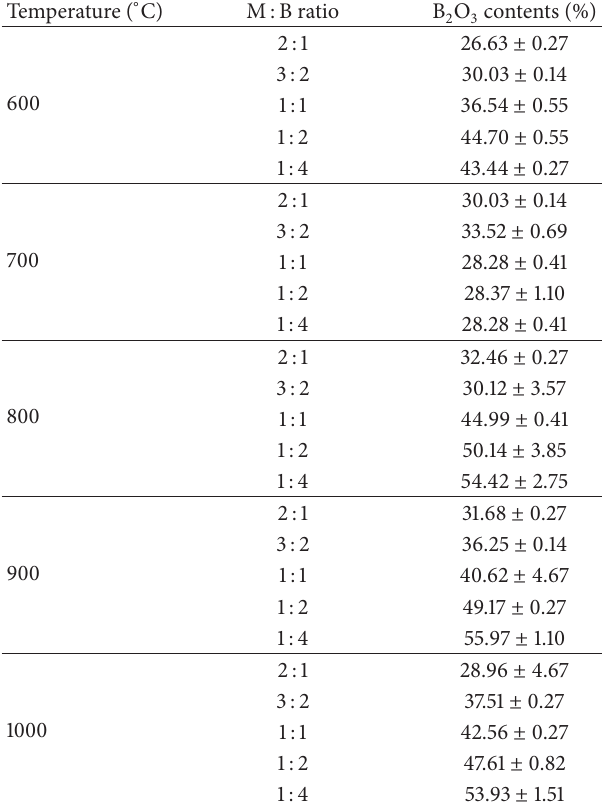
Table 3: Calculated B magnesium borate minerals.